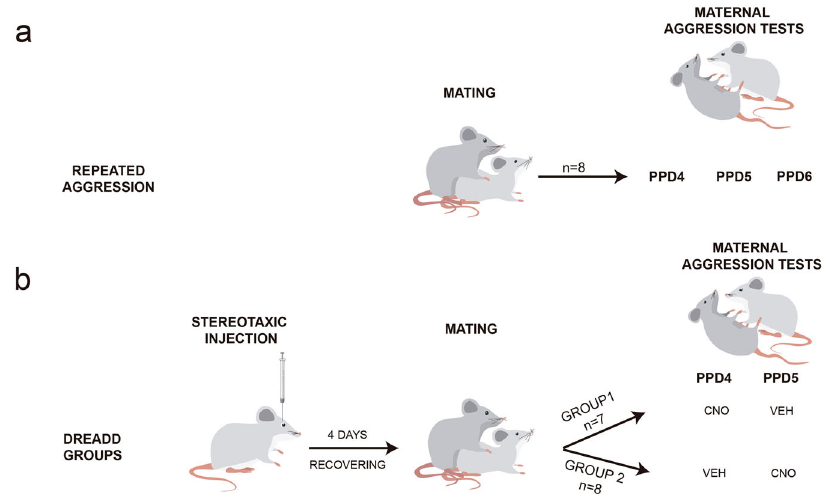
Fig. 1 Outline of the protocols followed in the study of maternal aggression behaviour. a In Experiment 1, repeated aggression, females were randomly assigned into two groups: dams ( n = 8) and pup-sensitised females ( n = 8) (not represented). On postpartum days (PPD) 4 – 6, both groups of females were exposed to a different intruder male each day. b In Experiment 2, effect of DREADD-inhibition of MeA in aggression, females had stereotaxic injections of DREADD-AAV in the MeA. Then, they were mated and randomly assigned to two groups. After parturition, for behavioural testing, we followed an intragroup design. Group 1 received i.p. injection of CNO in PPD4 and Veh in PPD5, and Group 2 received Veh injection in PPD4 and CNO in PPD5. Then, 30min after i.p. injections, females were exposed to a different male intruder each day. In parallel, we run two control groups of females, without DREADD injection, and the same drug regime, to discard any effect of CNO treatment (Supplementary information). CNO clozapine N-oxide, Veh